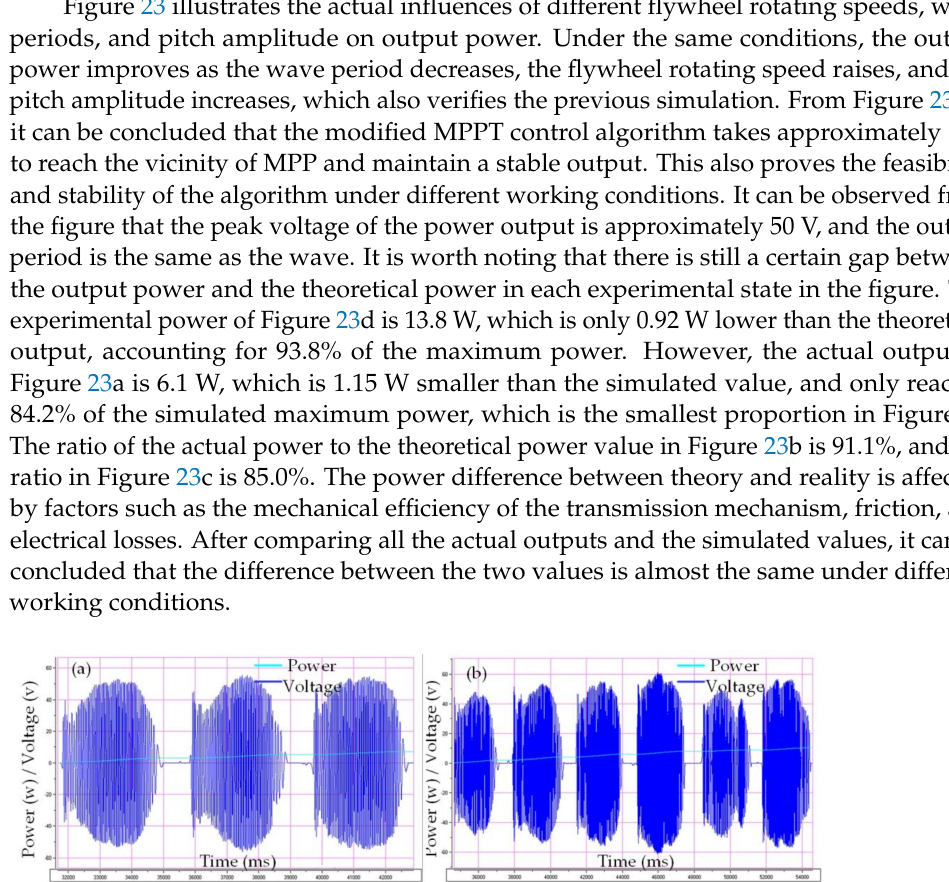
. ϕ = 10,000 rpm, T = 8 s, A = 10 ◦ , P = 6.1 W; . ϕ = 8000 rpm, T = 7 s, A = 10 ◦ , P = 7.4 W;